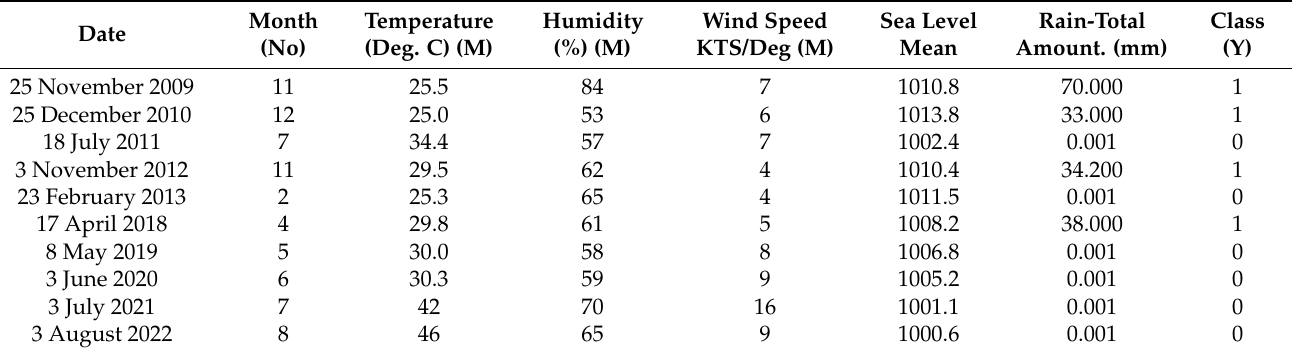
Table 2. Shape of dataset of Jeddah city weather for 10 years (2009–2013 and 2018–2022) (e.g., of nine